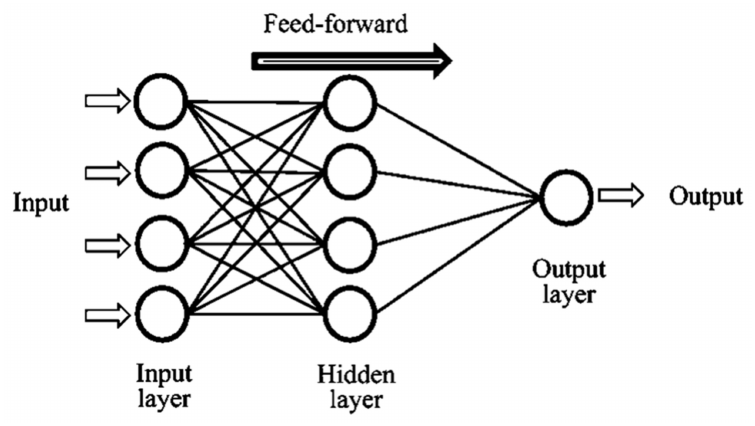
Figure 3. The function of the artificial neural network (ANN)